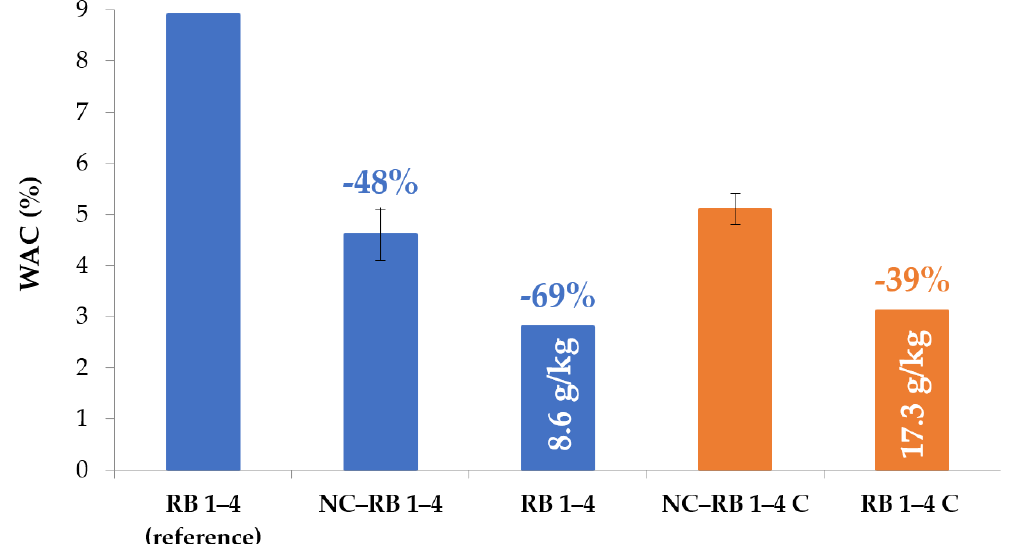
Figure 13. Effect of carbonation (natural and accelerated) on the WAC (one WAC measurement for each RCA after